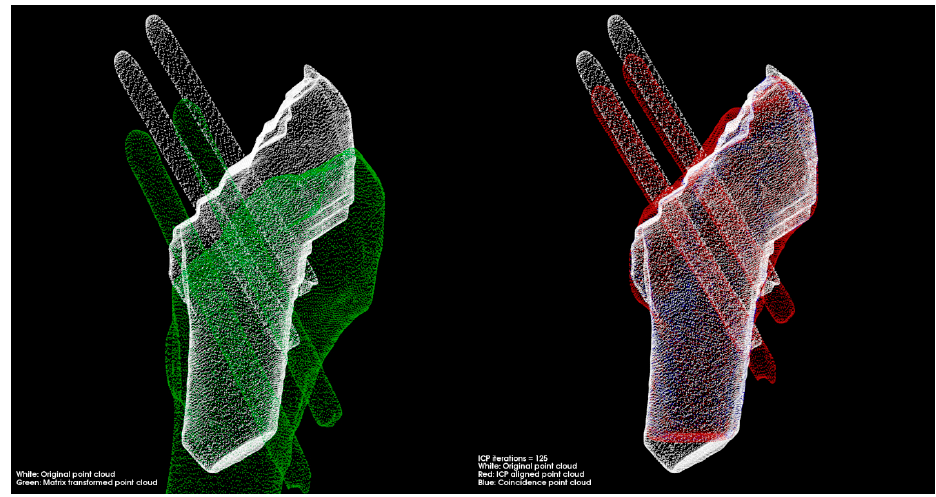
Figure 12. Performing position transformation on the pins and femur after registration with 125 iterations. We eliminated the femur part and quantitatively calculated the pins’ movement in the three-dimensional space. As shown in Figure 13, the principal component analysis was used to calculate the direction vector for obtaining relative angles, drawing the bounding box for the pins, and obtaining the endpoint coordinates. Meanwhile, the actual length of pins listed in Table 3 was used to calibrate the length scale of the point cloud